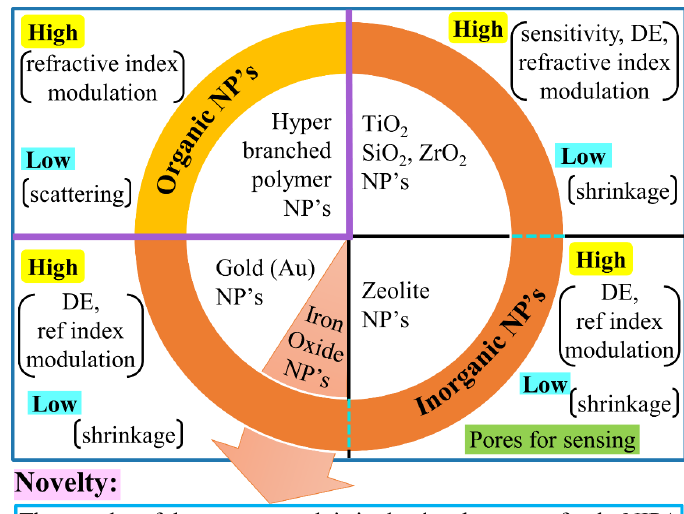
Figure 1. Summary schematic of the research work reported to date on the doping of nanoparticles into the holographic recording materials.